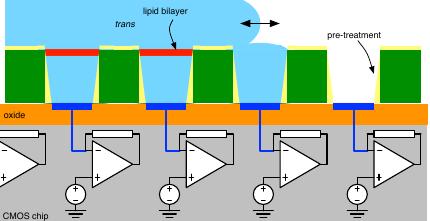
Figure 14. A micro-well array employed for automated membrane formation and pore